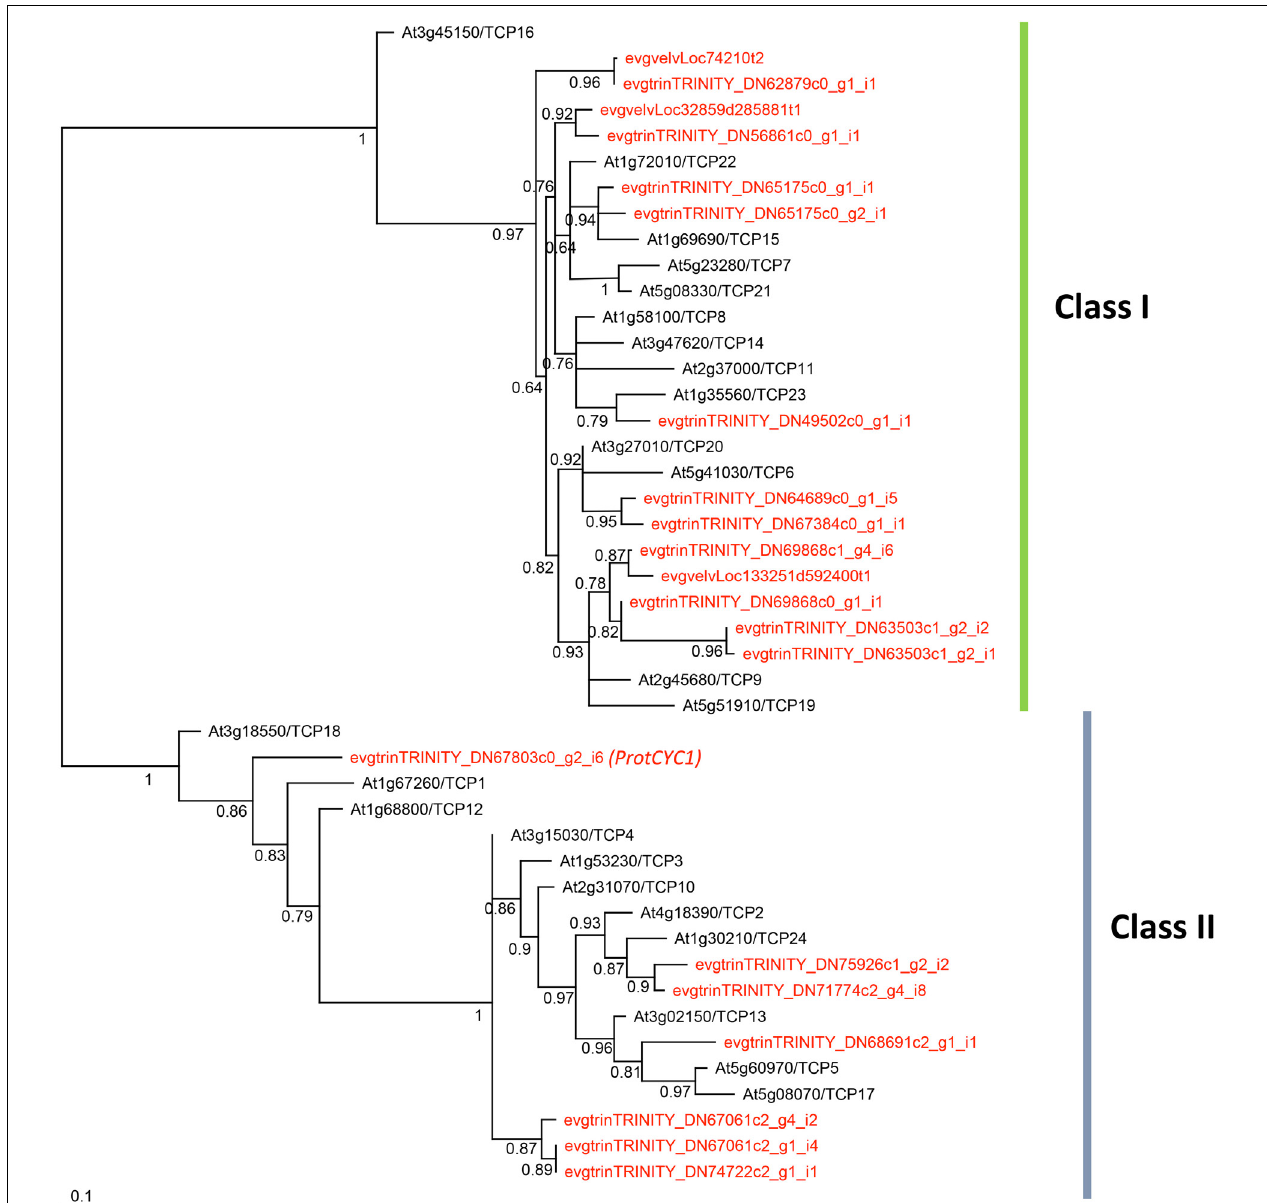
FIGURE 5 | Unrooted phylogram of TCP genes from the Arabidopsis thaliana genome and the Grevillea juniperina transcriptome (in red). 21 of the 24 G. juniperina transcripts were included in this analysis. Branches with less than 0.5 aLRT values were collapsed. Representatives of both class I and class II TCP genes were found in G. juniperina